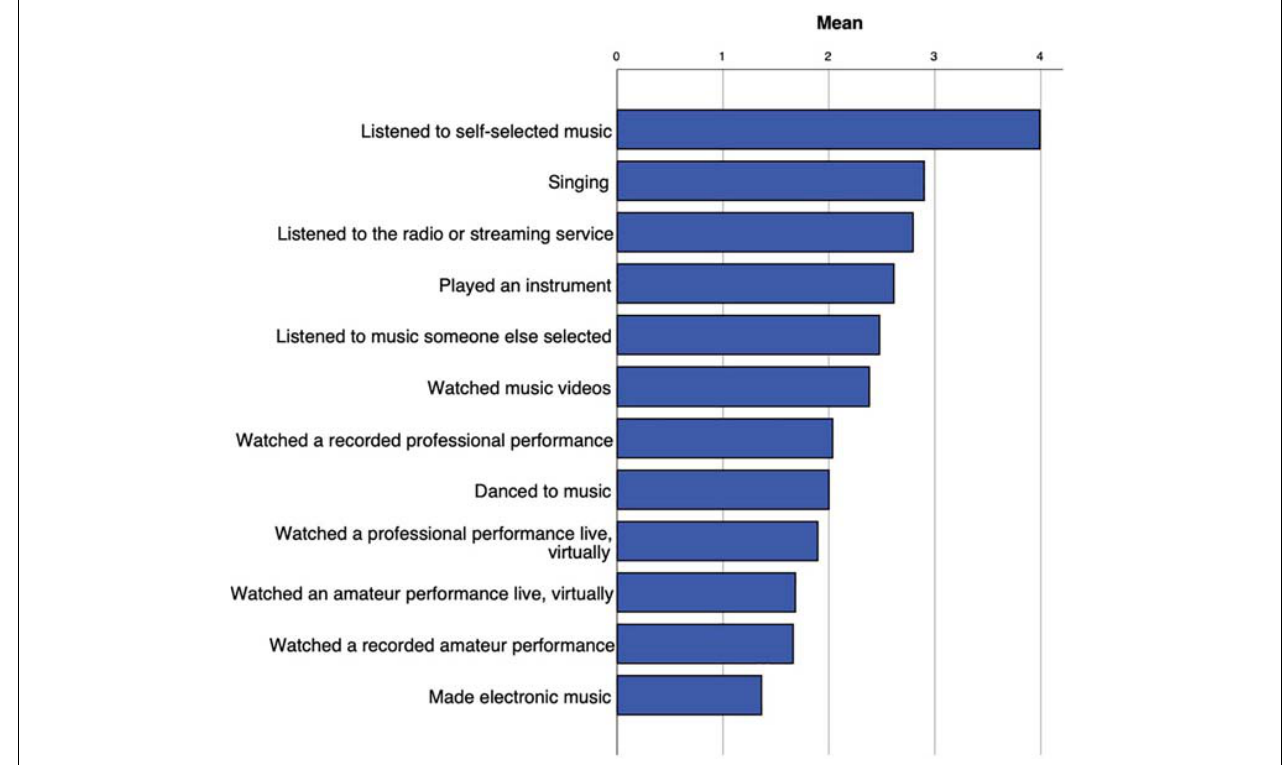
FIGURE 3 | Participants’ ratings of how frequently they engaged in particular music listening behaviors, ranging from not at all (0) to multiple times per day